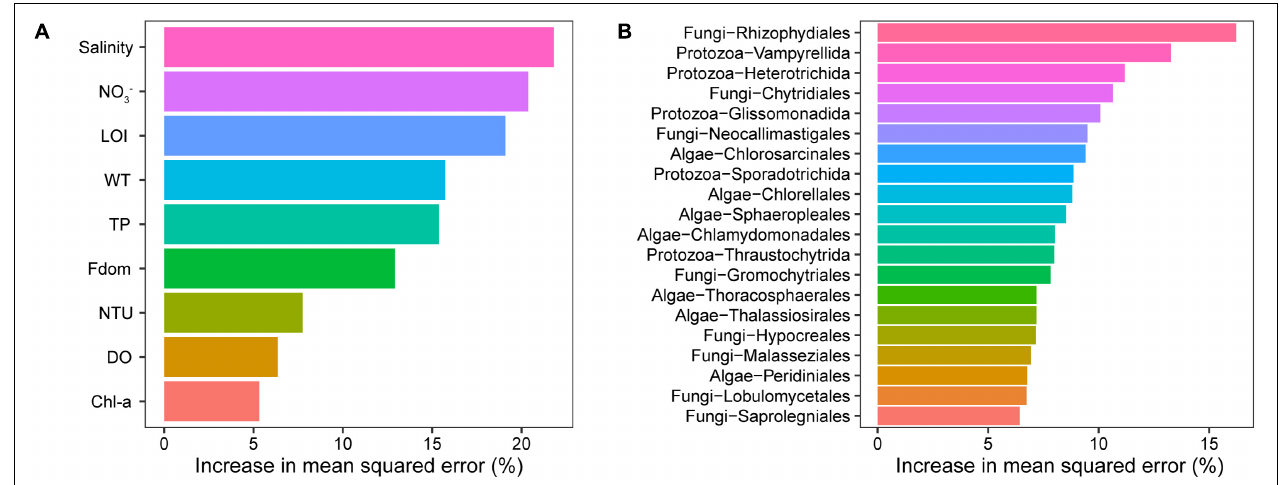
FIGURE 5 | Result of the RF model. (A) The relative importance of environmental variables to the microeukaryotic community. (B) Microeukaryotic biomarkers (order level) with salinity gradients in lake